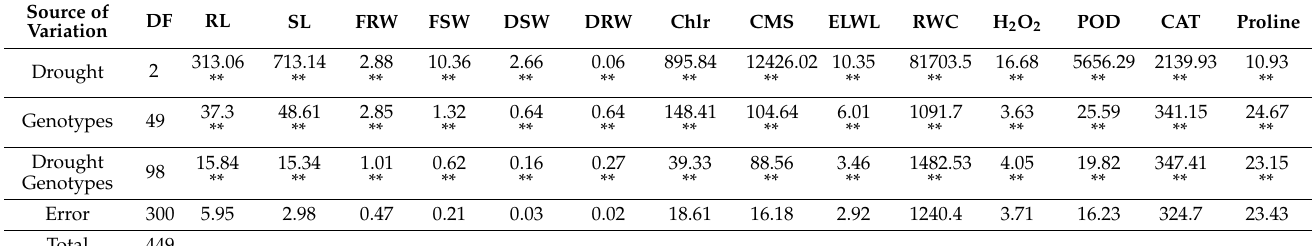
Table 3. Mean squares for various quantitative traits of cotton under drought